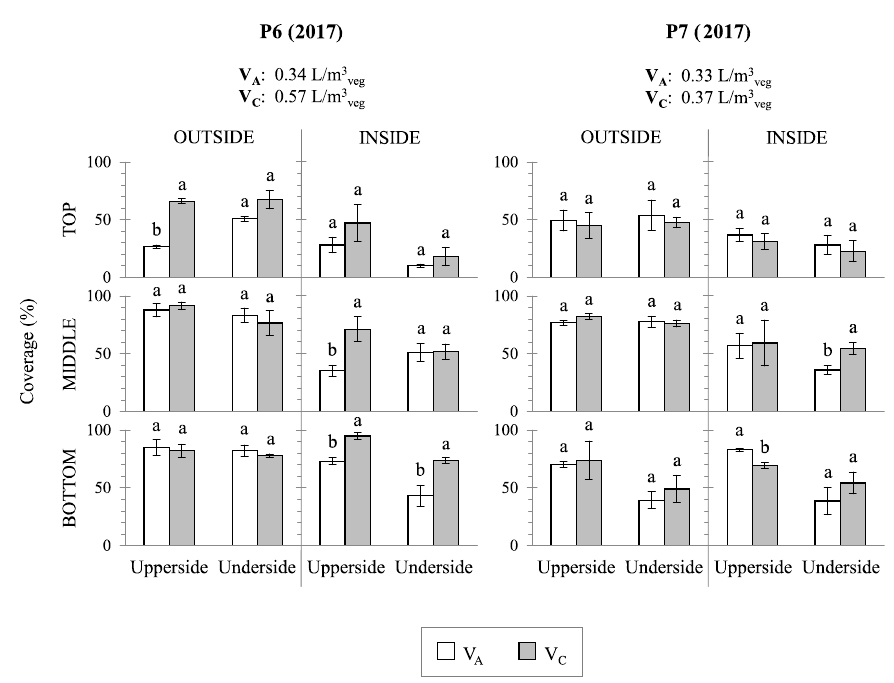
Figure A1. Mean ( ± standard error) coverage (%) per treatment (V A : adjusted volume, V C : conventional volume) at each height (top, middle, bottom) and depth (inside, outside) of the canopy, and side of the leaf (upperside, underside), in the different evaluations (combination of plot and year). The water volume is indicated in L/m 3vegetation . Different letters above the bars within each height × depth × side combination indicate significant differences (LSD test, p < 0.05).